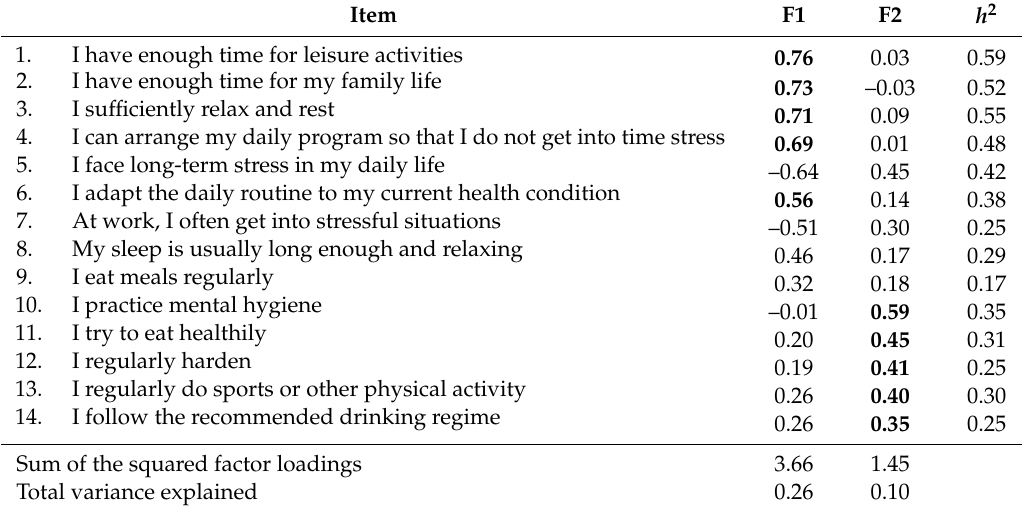
Table 1. Exploratory factor analysis (EFA) of the Teacher Lifestyle Scale—factor loading matrix. Item F1 F2 h 2